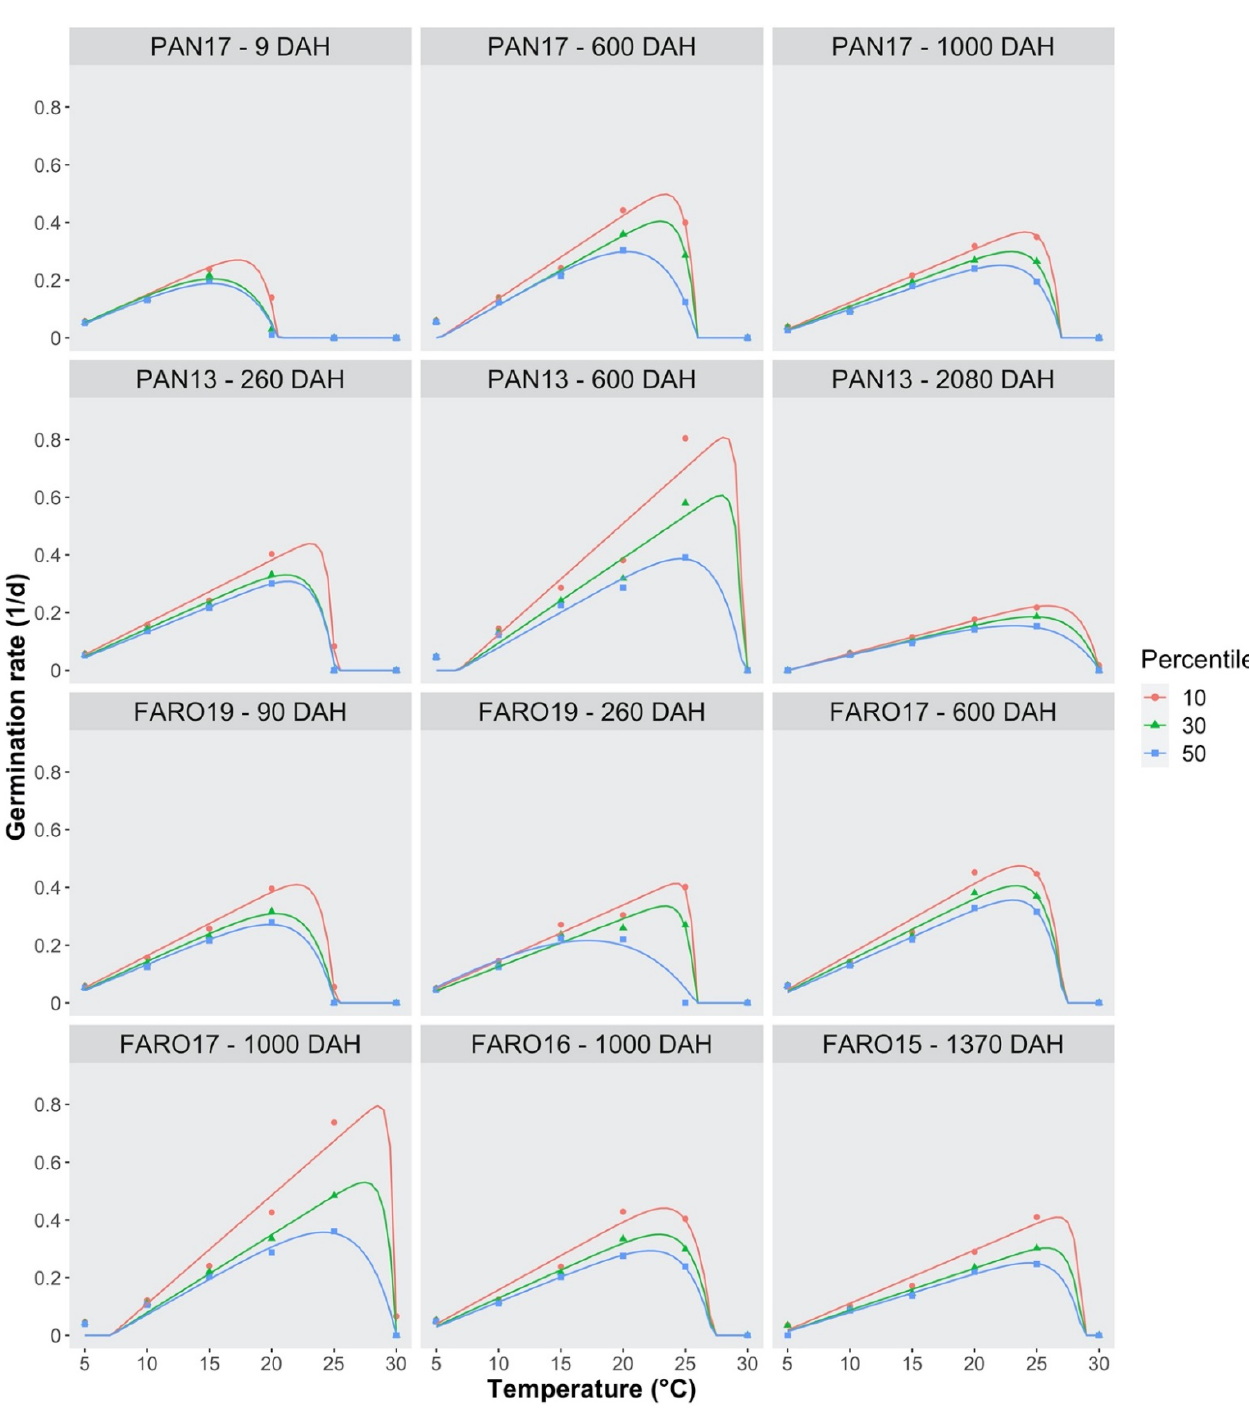
Figure 6. Effect of temperature on the germination rates for three germination percentiles (10th, 30th, and 50th) of S. hicesiae seeds, at seven seed ages (9, 90, 260, 600, 1000, 1370, and 2080 days after harvest = DAH), incubated at six constant temperatures (from 5 ◦ C to 30 ◦ C), under light/dark condition (L/D 12/12 h). Seeds were collected across five years (2013, 2015, 2016, 2017, and 2019) from two seed sources (PAN and FARO). The symbols show the observed data, whereas the lines show the predictions, according to Equation (1) and the parameters in Table 1. The maximum GR value at the optimal temperature increased with seed age. Con- sidering the 10th percentile, the value was lower than 0.3 d − 1 at 9 DAH (PAN17) and increased up to 0.5 d − 1 in PAN17 and to 0.8 d − 1 in PAN13 at 600 DAH. At higher